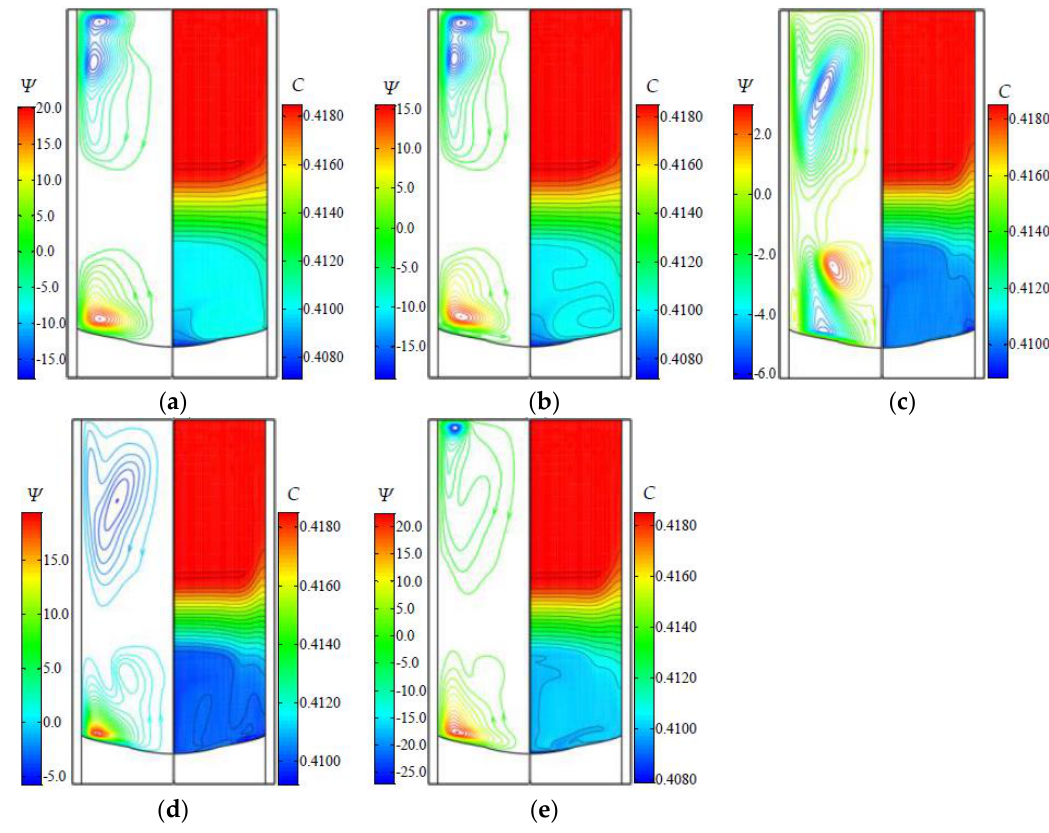
Figure 4. Flow ( Ψ (mm 3 /s)) and concentration ( C ) fields in the solution during the first half of the 5th period of ACRT Sequence 1. ( a – e ) Results at 5A–5E, respectively.